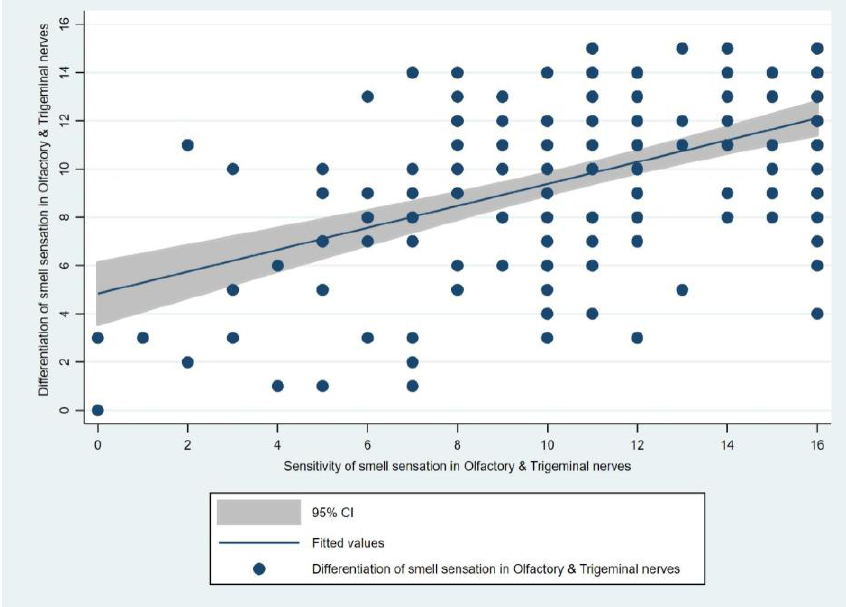
Figure 4. Correlation between sensitivity of smell sensation in olfactory and trigeminal nerve and differentiation capacity of smell sensation in olfactory and trigeminal